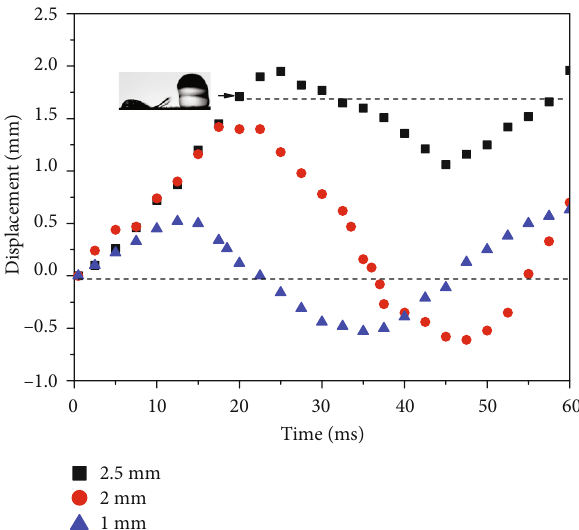
Figure 12: The variation of the droplet wetting diameter with time under di ff erent amplitudes. Figure 13: The variation of the droplet displacement with